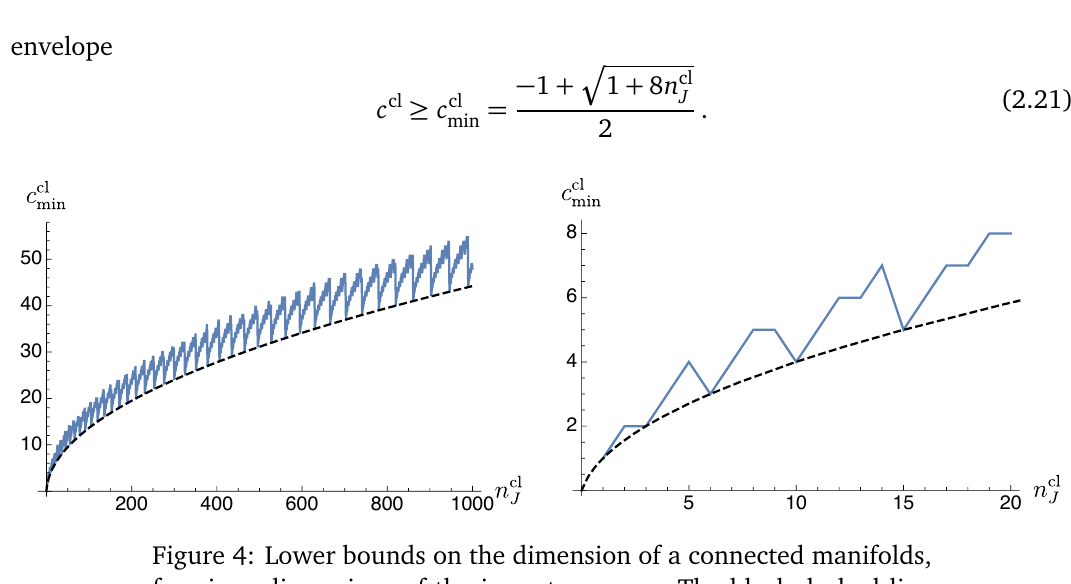
Figure 4: Lower bounds on the dimension of a connected manifolds, for given dimensions of the isometry group. The black dashed line shows the lower envelope